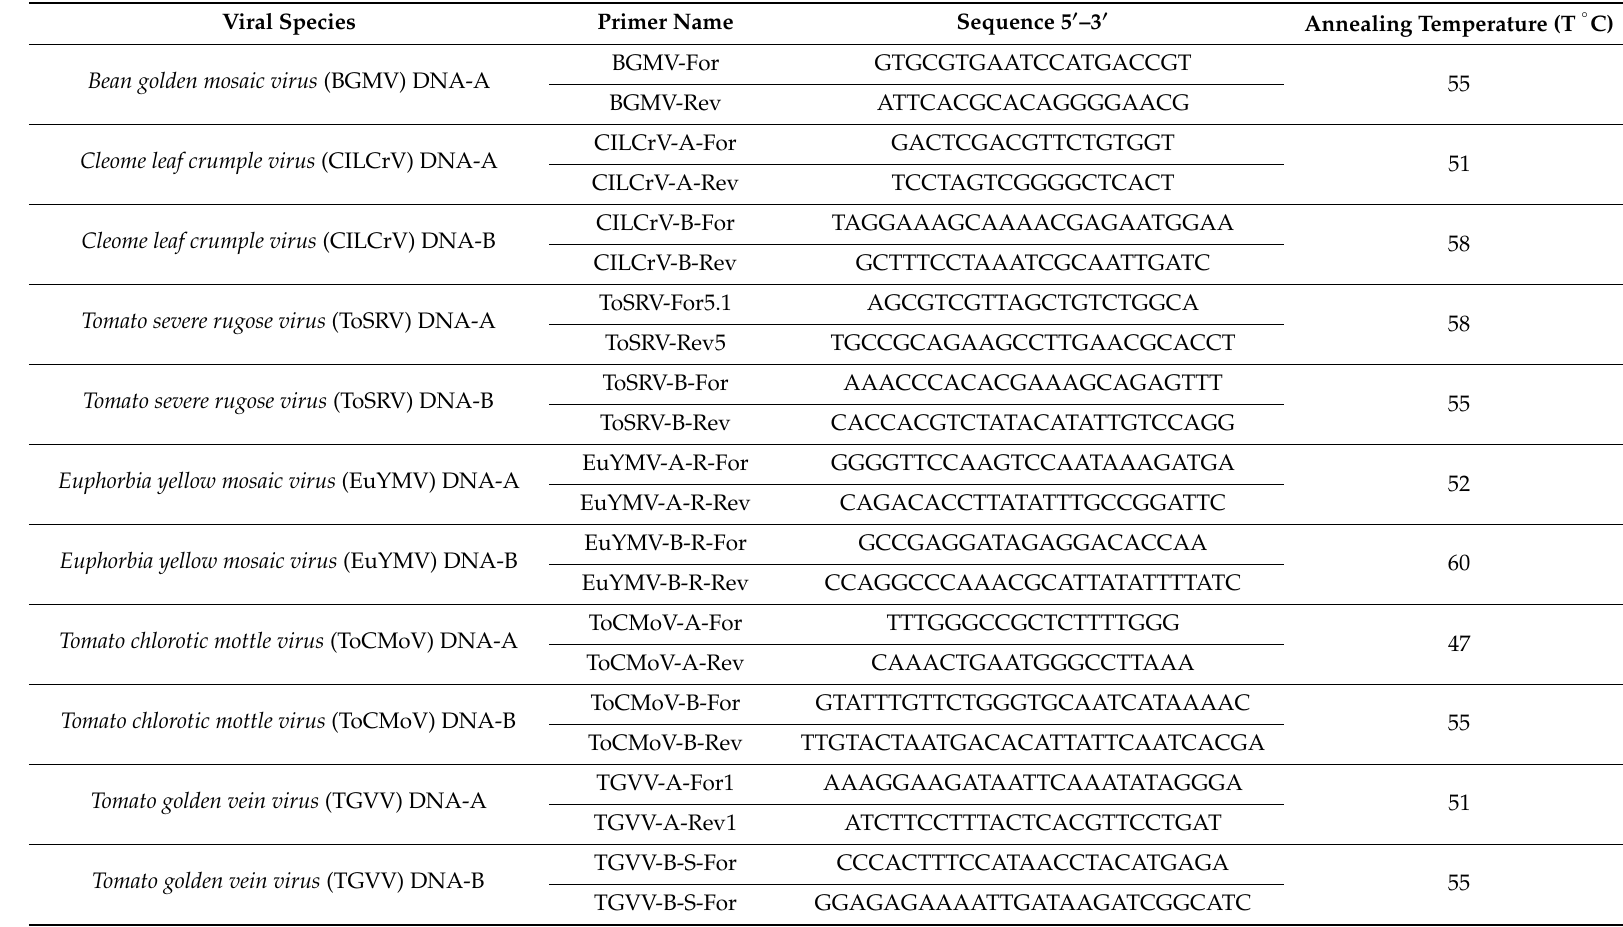
Table 3. PCR primer pairs designed on the basis of next-generation sequencing (NGS)-derived viral consensus sequences for validation of the Begomovirus species, as well as single-stranded DNA viruses and subviral agents identified in the tomato DNA sample pools (with the Ty -1 gene versus without the Ty -1 gene). For = forward and Rev = reverse